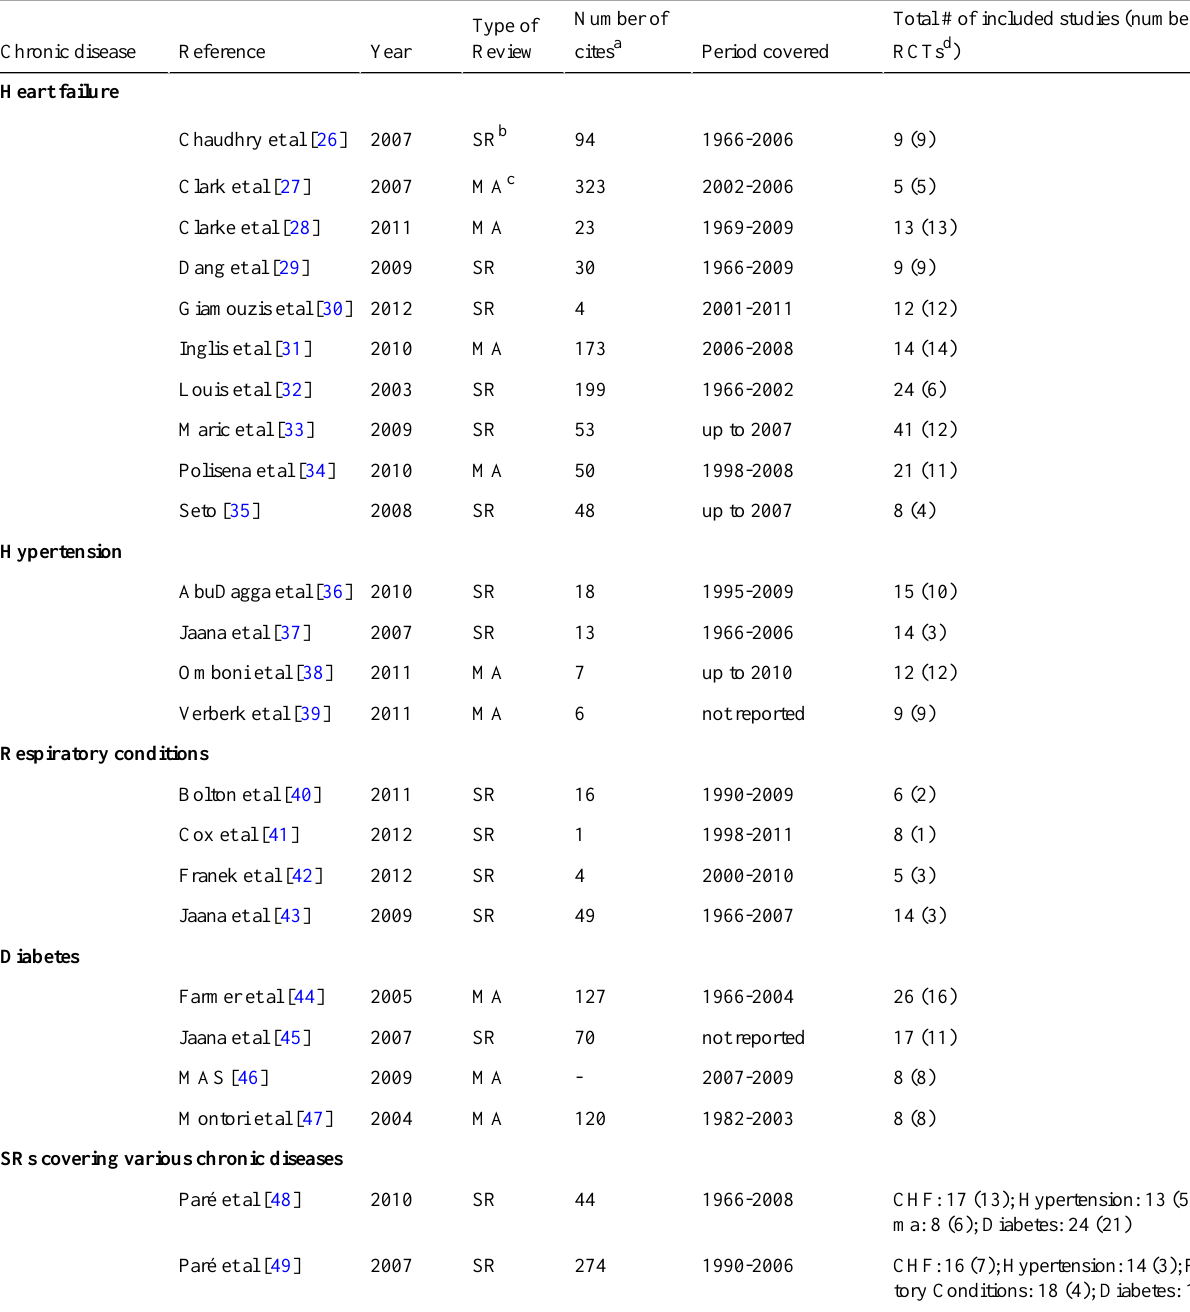
Table 1. Profile of the reviews.